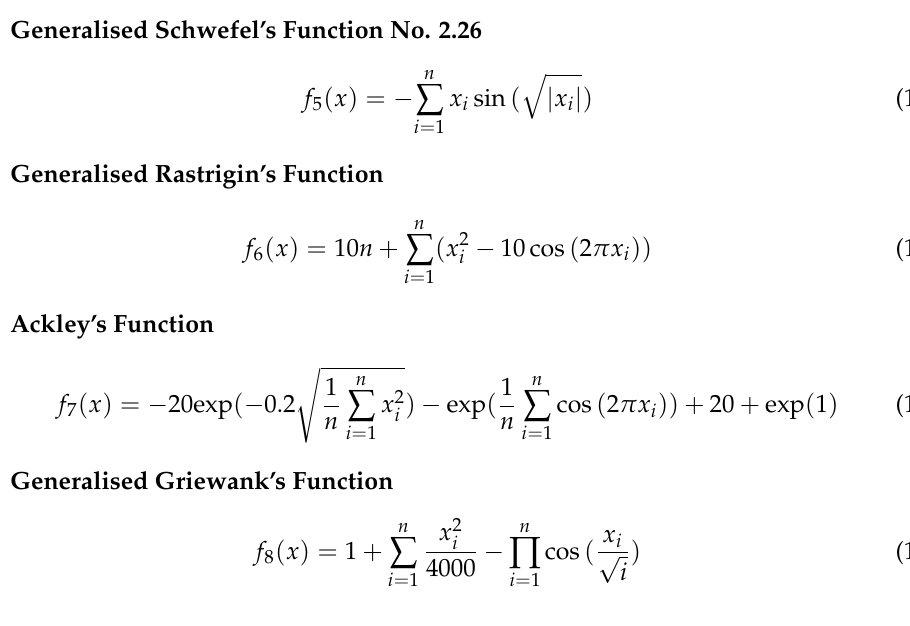
Figure 5. Unimodal benchmark mathematical functions f 3 and f 4 in a 3D view. Multimodal